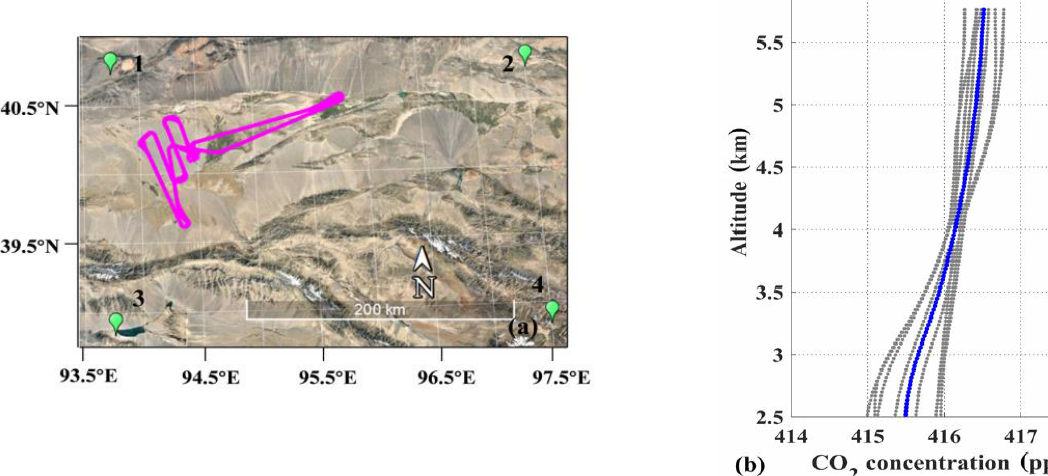
Figure 10. Distribution of the CAMS model data points in the flight area ( a ) and the CO 2 concentration vertical structure calculated by the CAMS model ( b ). In Figure 10a, the green points represent the locations of the CAMS mode grid data. The solid pink line is the flight route of the plane on 19 July 2021. In Figure 10b, the gray scatters represent the results at different heights for all CO 2 concentrations of point 1 in the figure, and each gray profile represents the calculation results at different times at point 1. The blue scatters represent the average of all grey scatter points at different heights (© Google Earth Pro).